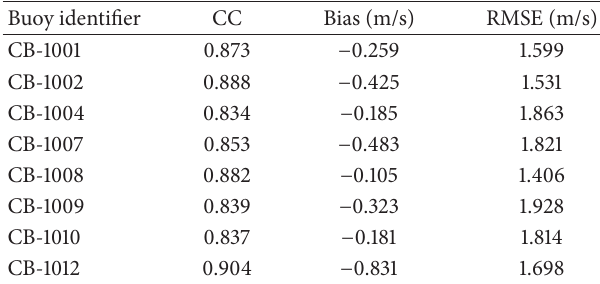
Table 1: Statistical errors of observed (buoy)/satellite (ECMWF) 10 m wind speed data comparison for the period of 2015 in the ECS: correlation coefficient (CC), bias (m/s), and root mean square error